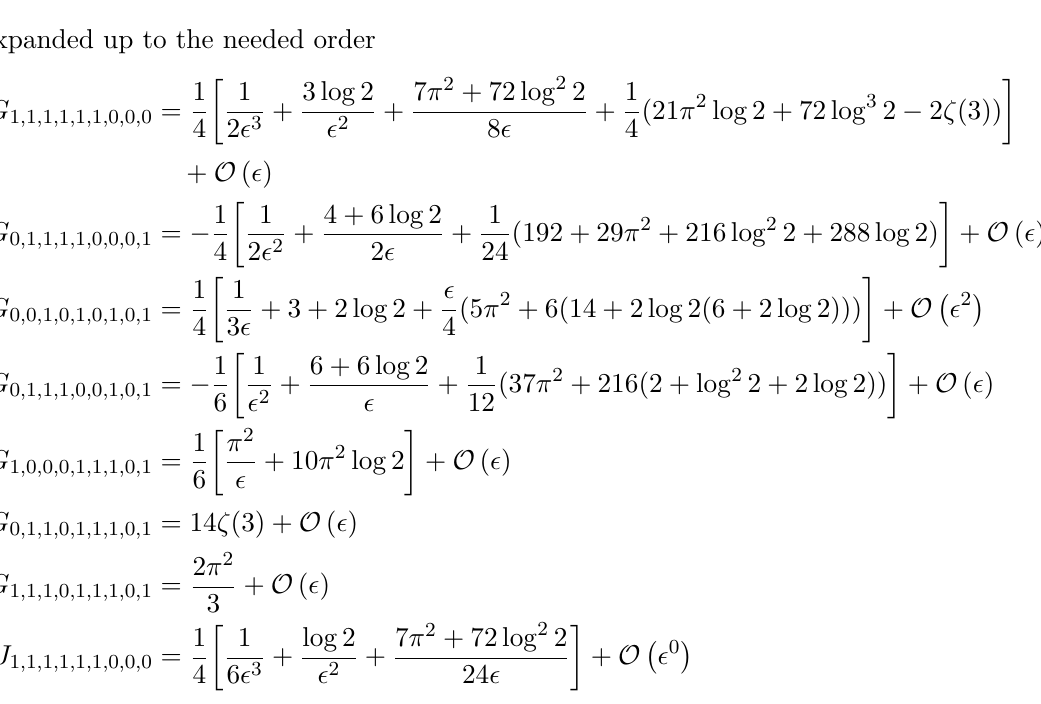
Figure 15 . Three loop master